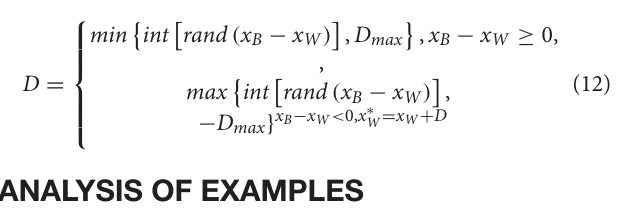
relationship of the codes corresponding to the best emergency plan, and the accuracy of local optimization can be